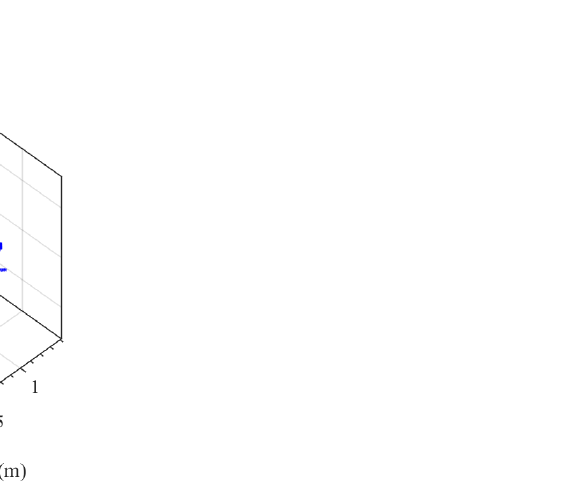
Figure 20. Attitude angle when the FMAV hovers in the air.